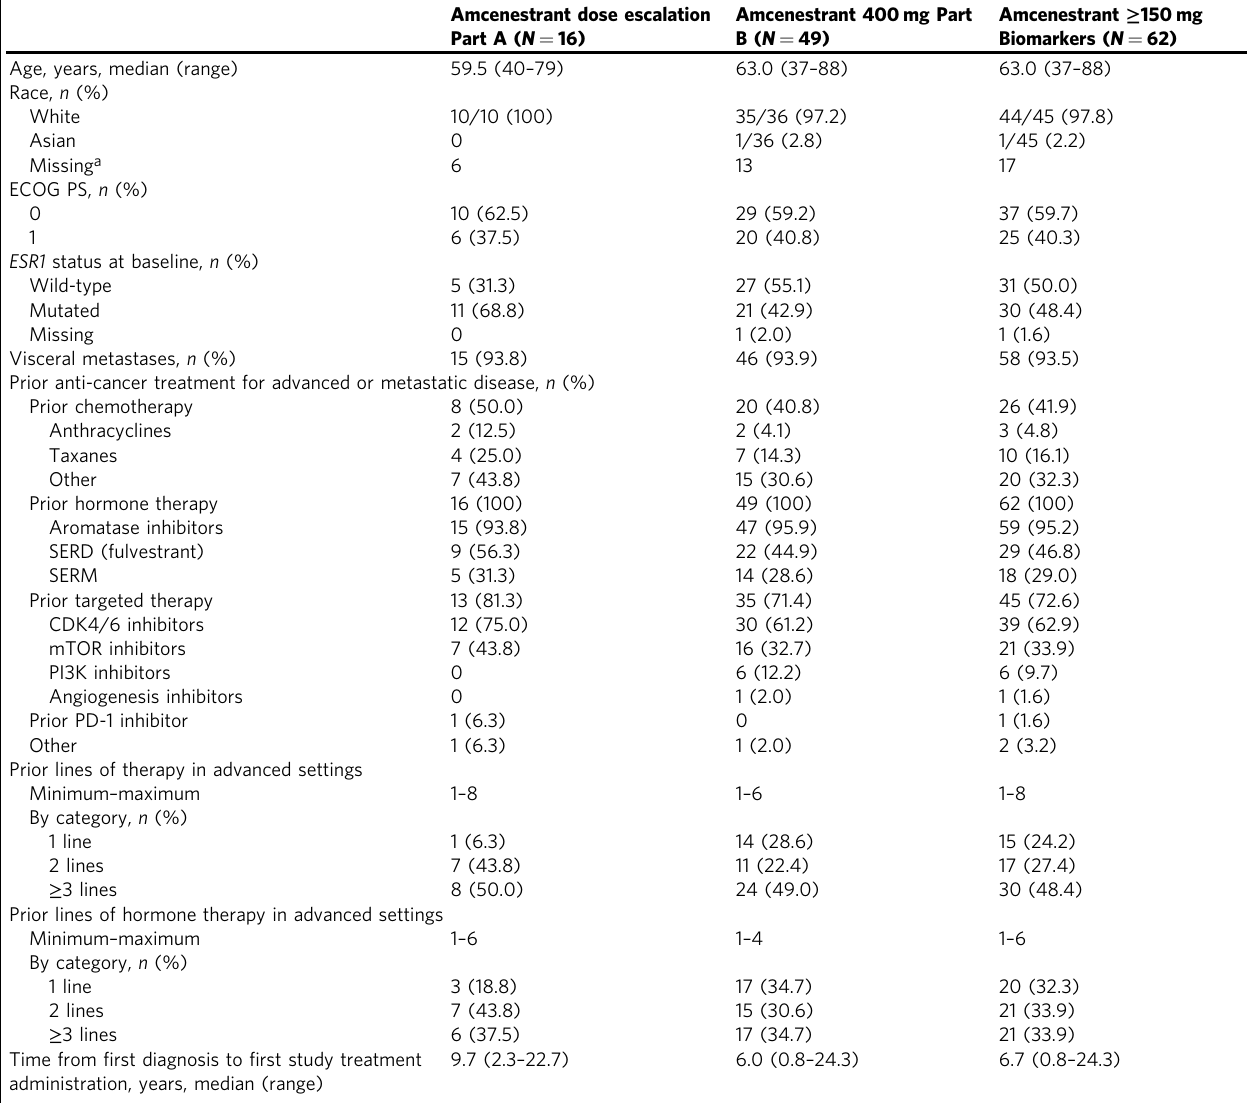
Table 2 Demographic and patient characteristics at baseline in Parts A and B (safety populations) and the biomarker population (Parts A and B excluding the amcenestrant QD 20-mg